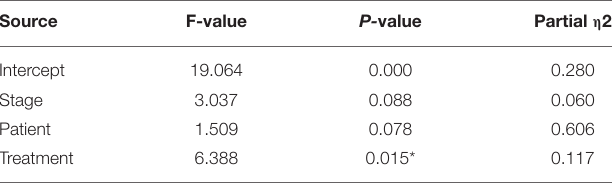
TABLE 2 | Cross-analysis of the decrease in the VAS score.